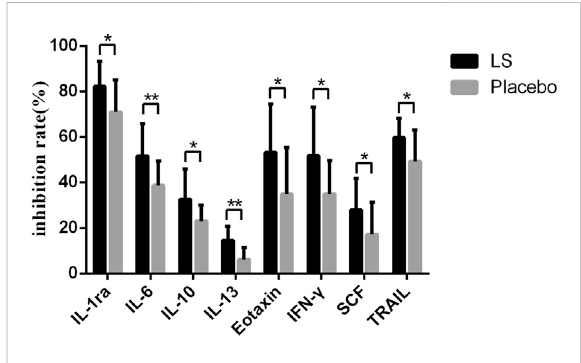
FIGURE 2 In fl ammatory factors in the start- and end-LS groups.